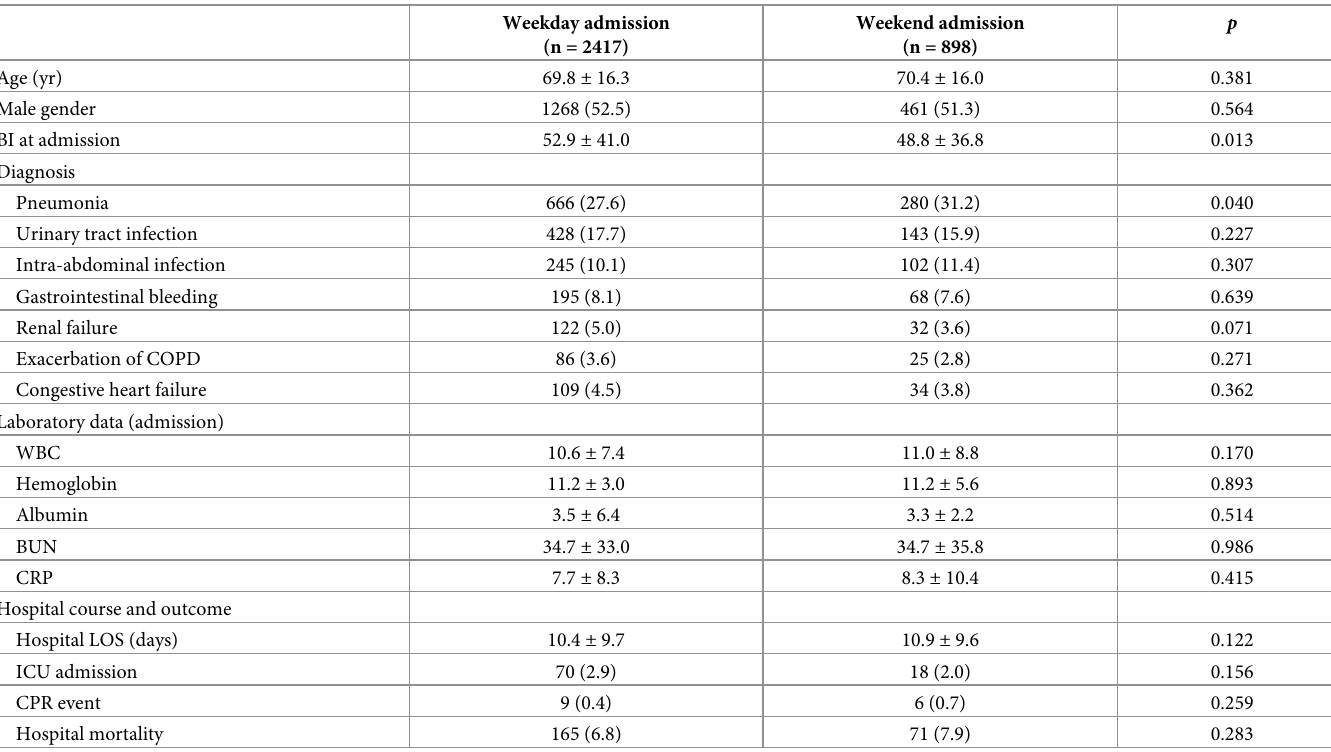
Table 4. Clinical characteristics and outcomes of the three-year follow-up cohort with comparisons between weekday and weekend admissions.